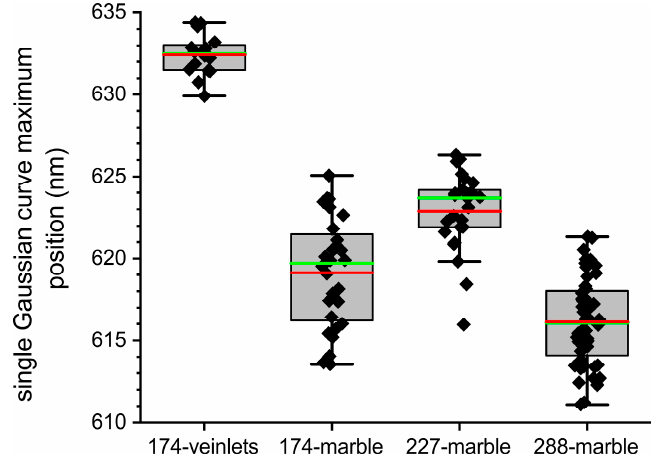
Figure 5. Box plot of the position of the maximum extrinsic luminescence derived from a single Gaussian curve fit. The extent of the box is the 25–75 percentile (Q1–Q3 quartile), the red line = mean, the green line = median. The data for veinlets and groundmass were processed separately (sample